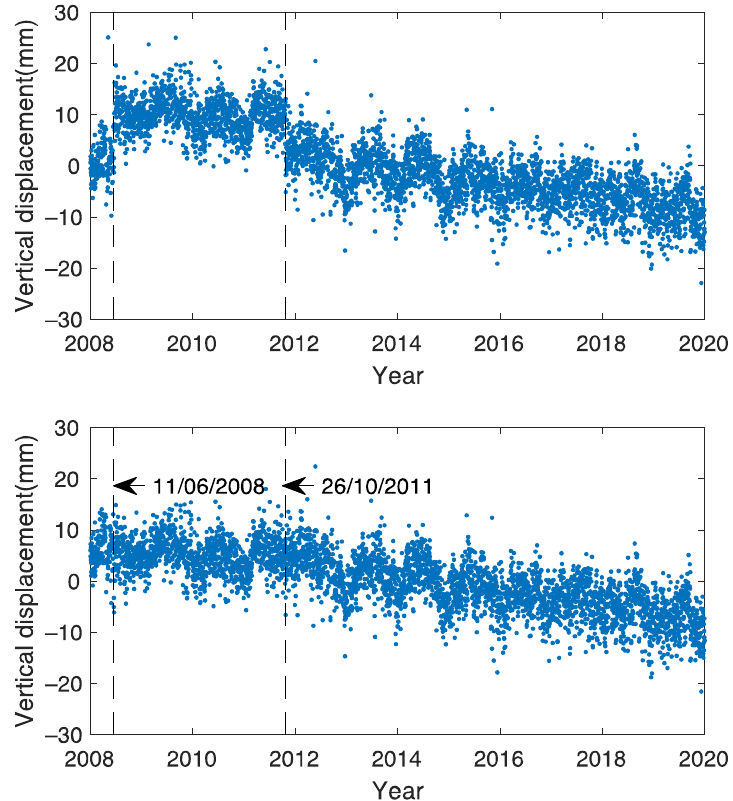
Figure A9. The differences in relative sea levels measured by GNSS-IR at BRST and the co-located tide-gauge records. GNSS station and tide gauge are 293 m apart. Blue dots are the difference be- tween the two types of measurements, while the red line is the fit to the differences. The two dash lines indicate change of equipment: the GNSS antenna changed from LEIAT504 to LEIAT504GG on 11 June 2008, and from LEICA (LEIAT504GG) to TRIMBLE (TRM57971.00) on 26 October 2011.